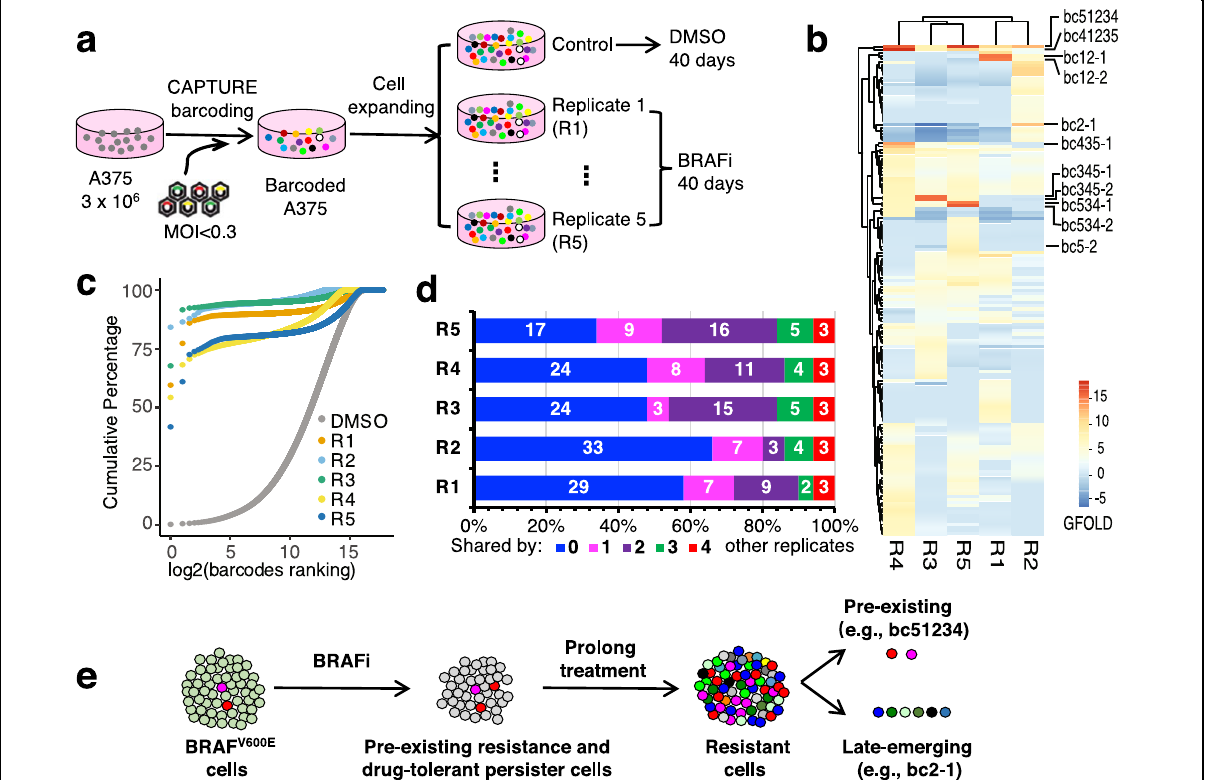
Fig. 2 CAPTURE barcoding demonstrates the evolution of PLX-resistant subclones. a Schematic outline of the experimental design. b Heatmap of enriched barcodes (GFOLD log 2 fold change > 4) from all replicates compared with vehicle control group. c Cumulative plot of barcode percentages. The shift of the PLX-treated groups represents the enrichment in a subset of barcodes. d Percentage of enriched barcodes in each replicate that were also found in other replicates. e Model demonstrating both selection of preexisting resistance cells and late-emerging resistance cells from drug-tolerant persister cells fuel BRAFi resistance in BRAF V600E